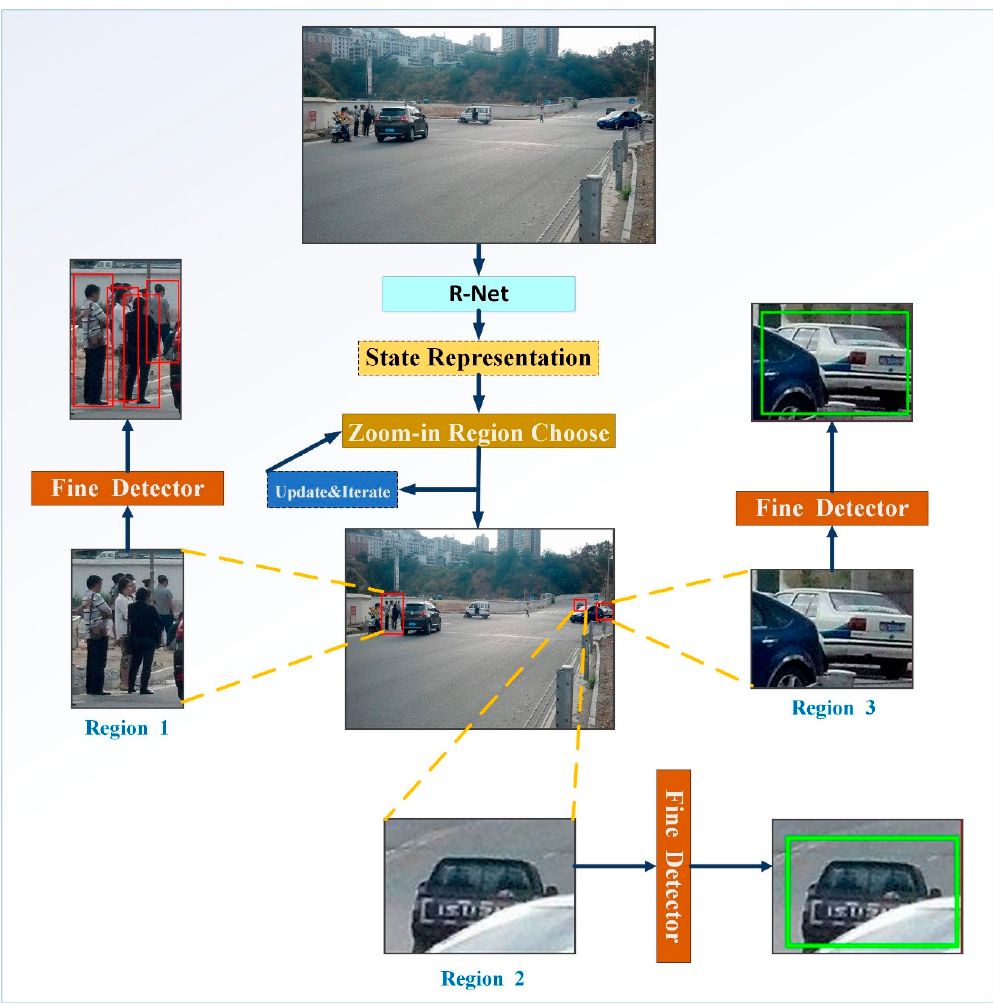
Figure 6. Network Architecture of Dynamic Region Enlargement Algorithm.